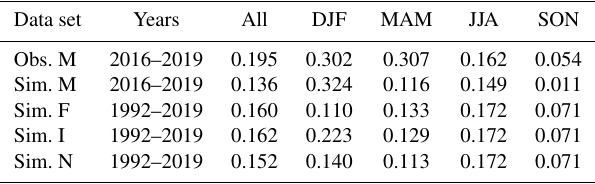
Table 2. Kendall rank correlation coefficients ( τ ) between the ob- served (Obs.) and simulated (Sim.) significant wave heights and sea levels in four seasons: winter (DJF), spring (MAM), summer (JJA), and autumn (SON). The data set “Sim. M” includes the simu- lated significant wave heights from the same periods as the data set “Obs. M” contains observations, thus being a subset of “Sim. F” of the years 2016–2019. Data